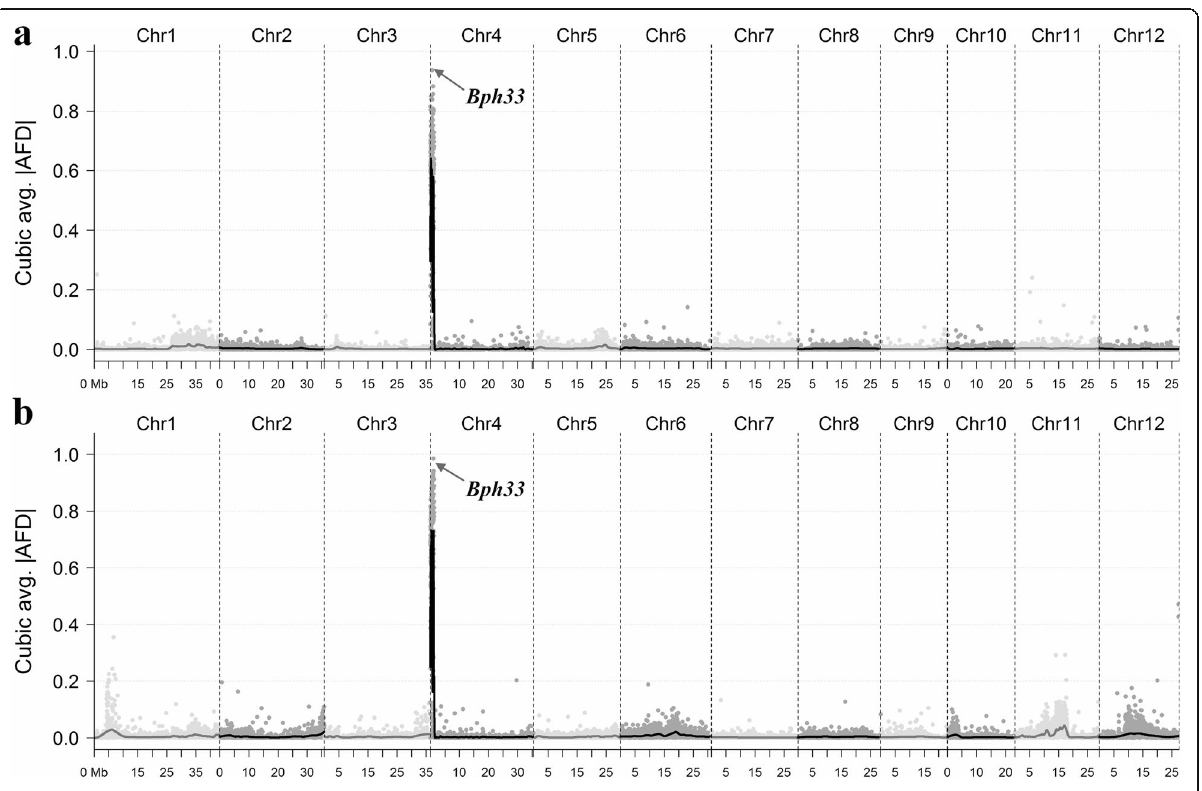
Fig. 2 Mapping of Bph33 using the method of BSA-seq based on the F 2:3 populations from 9311 × KOLAYAL ( a ) and 9311 × POLIYAL ( b ). AFD, allele frequency difference of individual marker between the two opposite DNA pools. The arrows indicate the peaks where Bph33 was